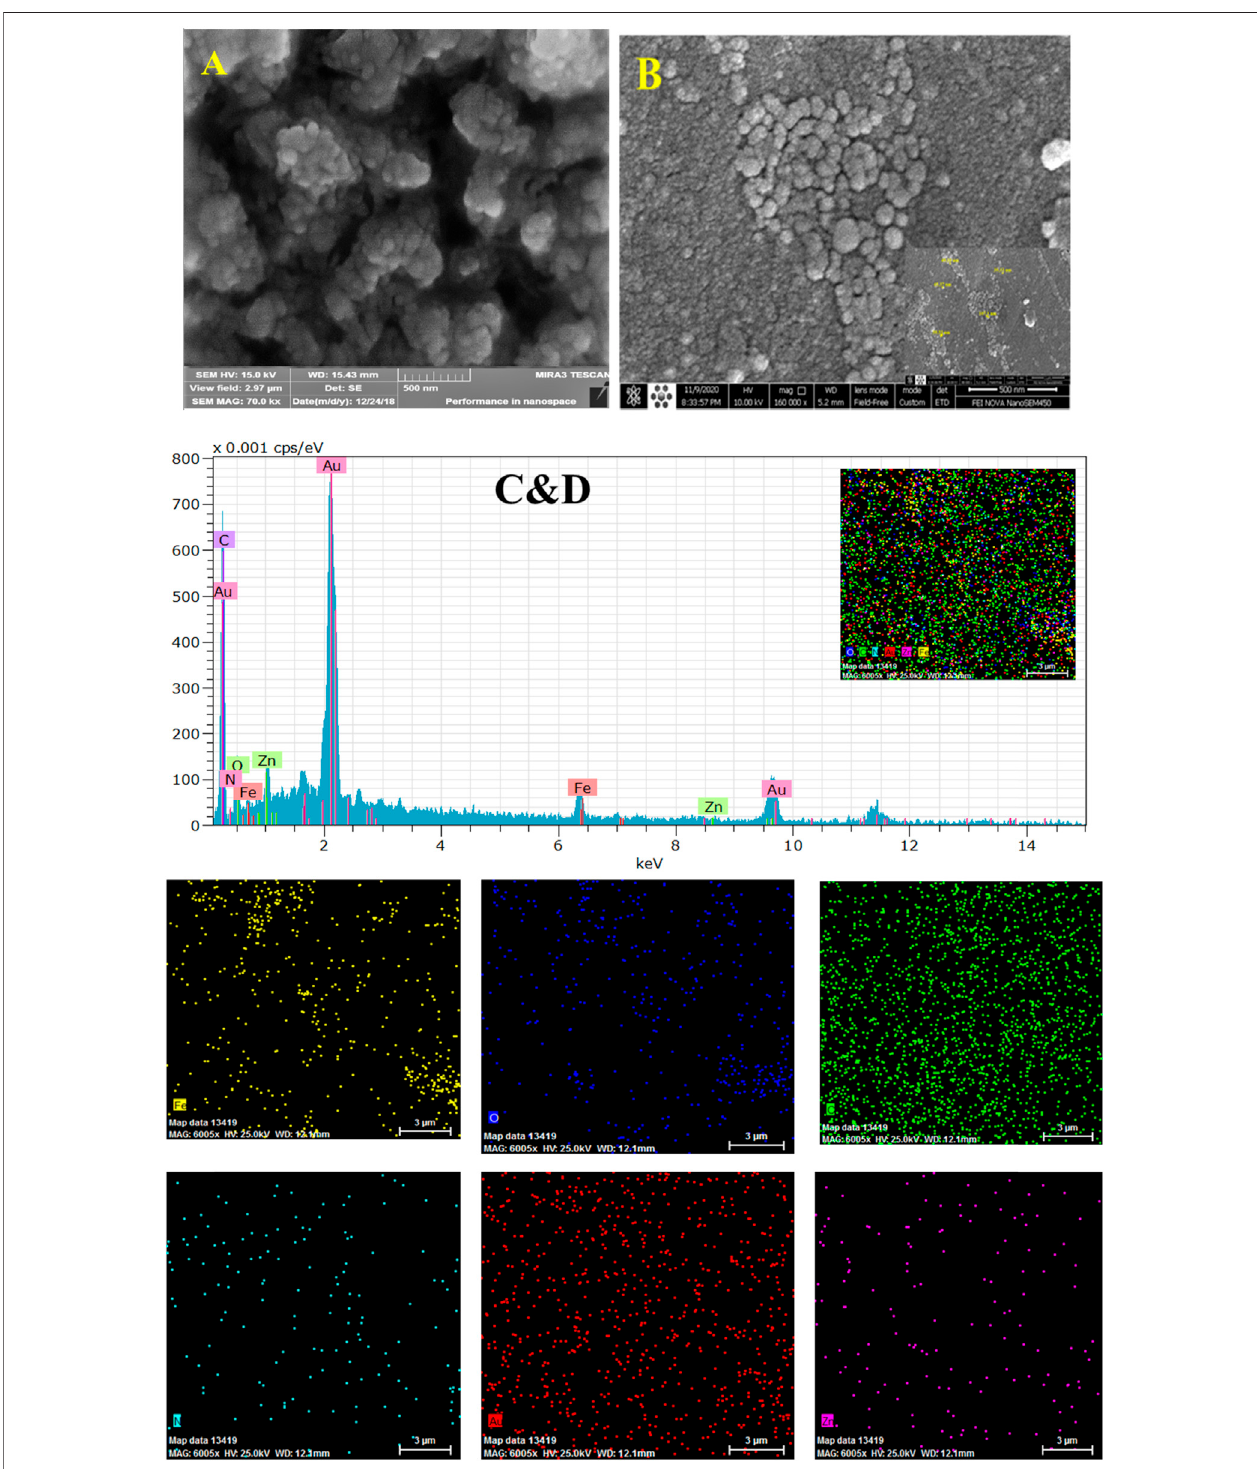
FIGURE4| SEMimages ofGCE/Fe 3 O 4 @TMU-24 (A) ,and GCE/Fe 3 O 4 @TMU-24-AuNPs (B) ,EDX mappingand EDX spectrum recorded atGCE/Fe 3 O 4 @TMU- 24 -AuNPs elemental different showing signal of Au, C, O, N, Fe, and Zn respectively, as is illustrated (C,D) .